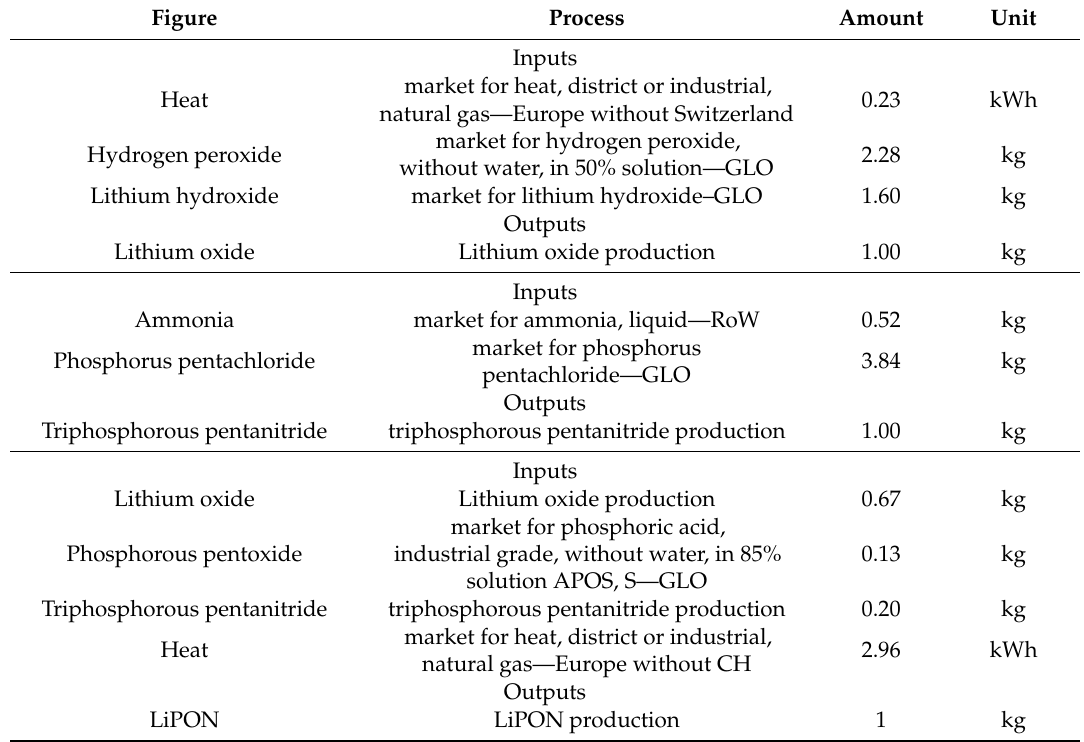
Table 3. LCI for the LiPON electrolyte production. Figure